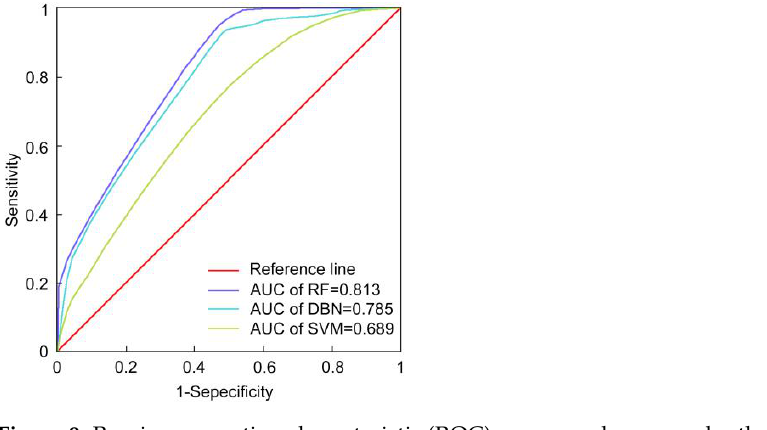
Figure 9. Receiver operating characteristic (ROC) curves and areas under the curve (AUCs) of the three models.